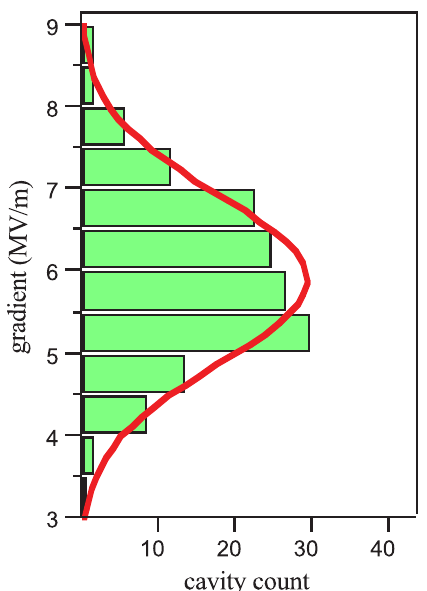
FIG. 10. Modeled gradients for arc fault intervals of four days (from